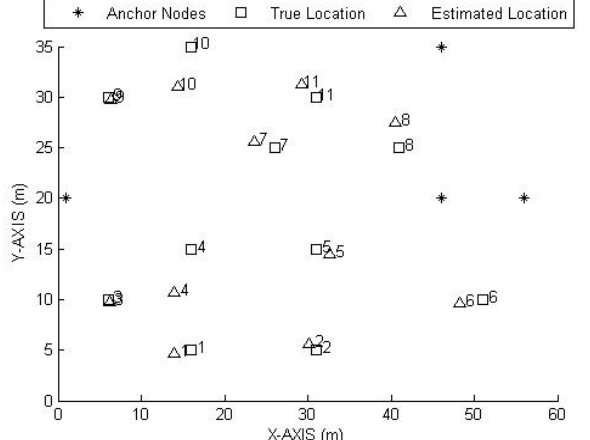
Figure 7. Comparison between true location and estimated location due to non-metric